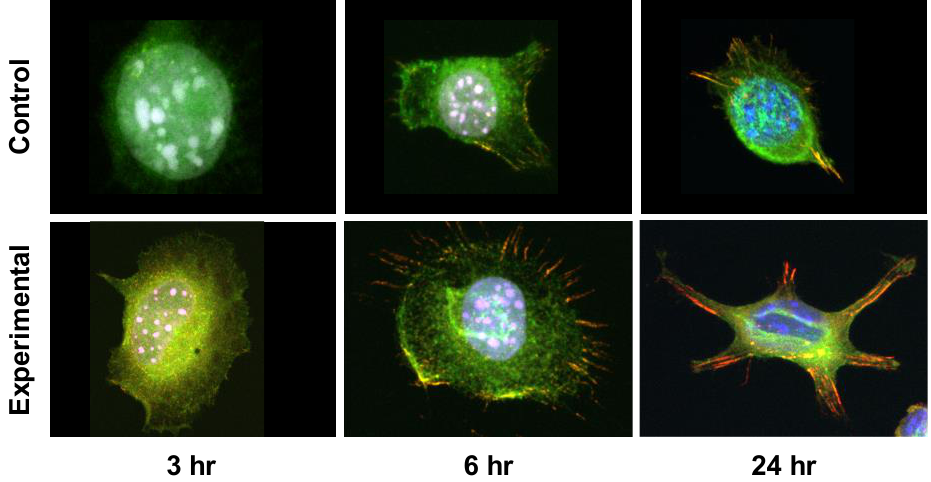
Figure 6. Immunocytochemistry of vinculin. Immunocytochemistry reveals vinculin expression within the elongated microspikes of fibroblasts. Furthermore, the elongation of vinculin-expressing thick spikes was observed at 24 h. (Vinculin: red, DAPI: blue, Phalloidin: green).